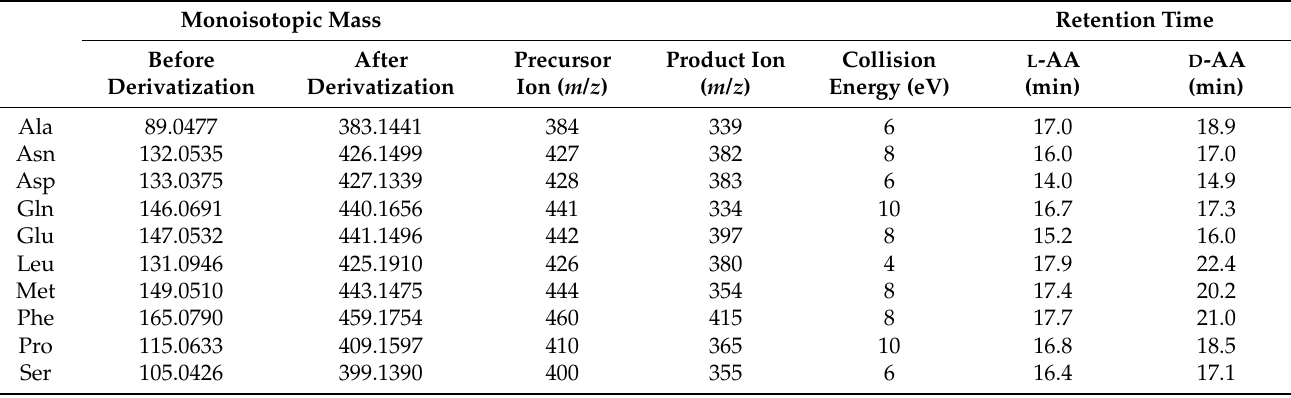
Table 1. Multiple reaction monitoring (MRM) settings and retention time for the derivatized L - and D -amino acids. Standard L - and D -amino acids (AA) were derivatized with L -FDLA and measured by LC/MS/MS with positive ESI mode. The monoisotopic mass of standard amino acids before and after the derivatization (Da), precursor ion ( m / z ), product ion ( m / z ), collision energy (eV), and retention time (min) were